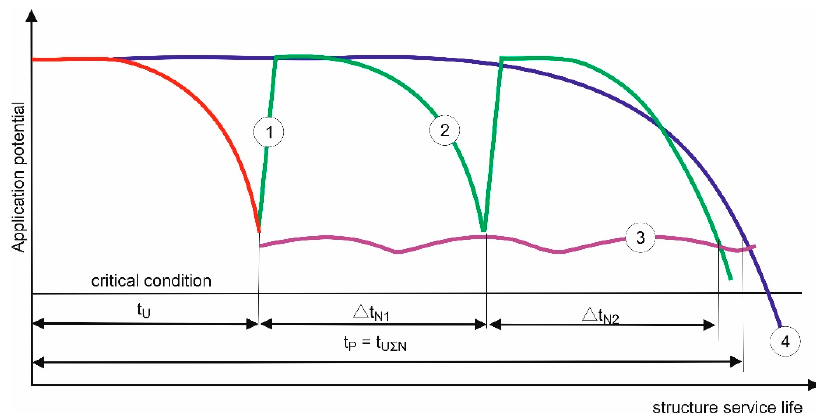
Figure 3. Typical repair cycles during the service life of a building structure subjected to degradation